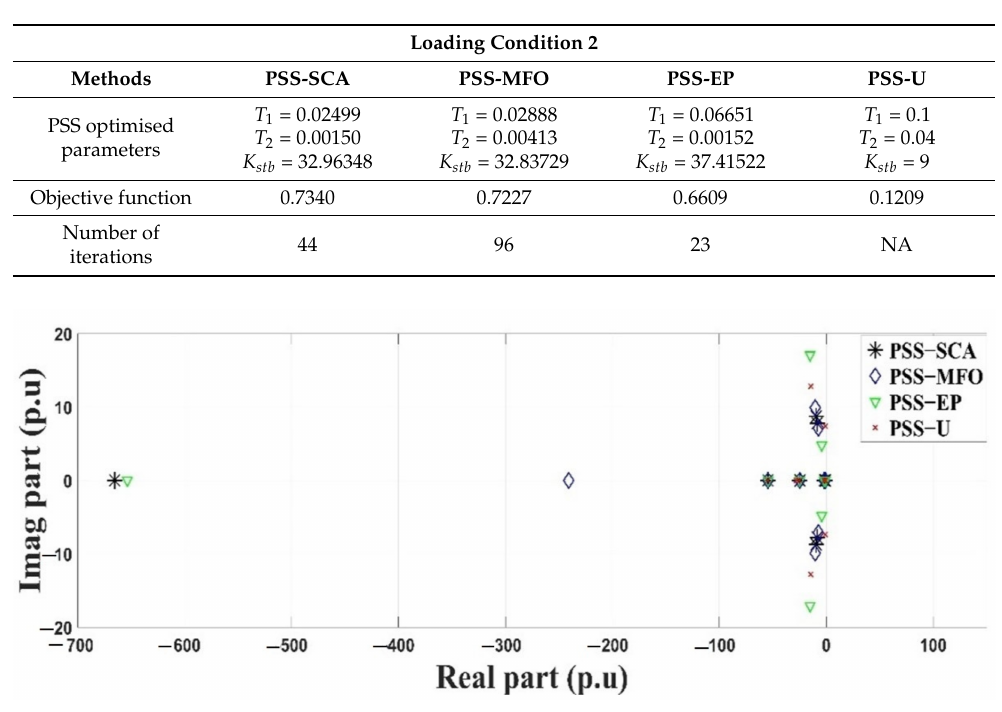
Figure 8. Eigenvalue’s location on the complex s-plane for loading condition 2 of the SMIB with